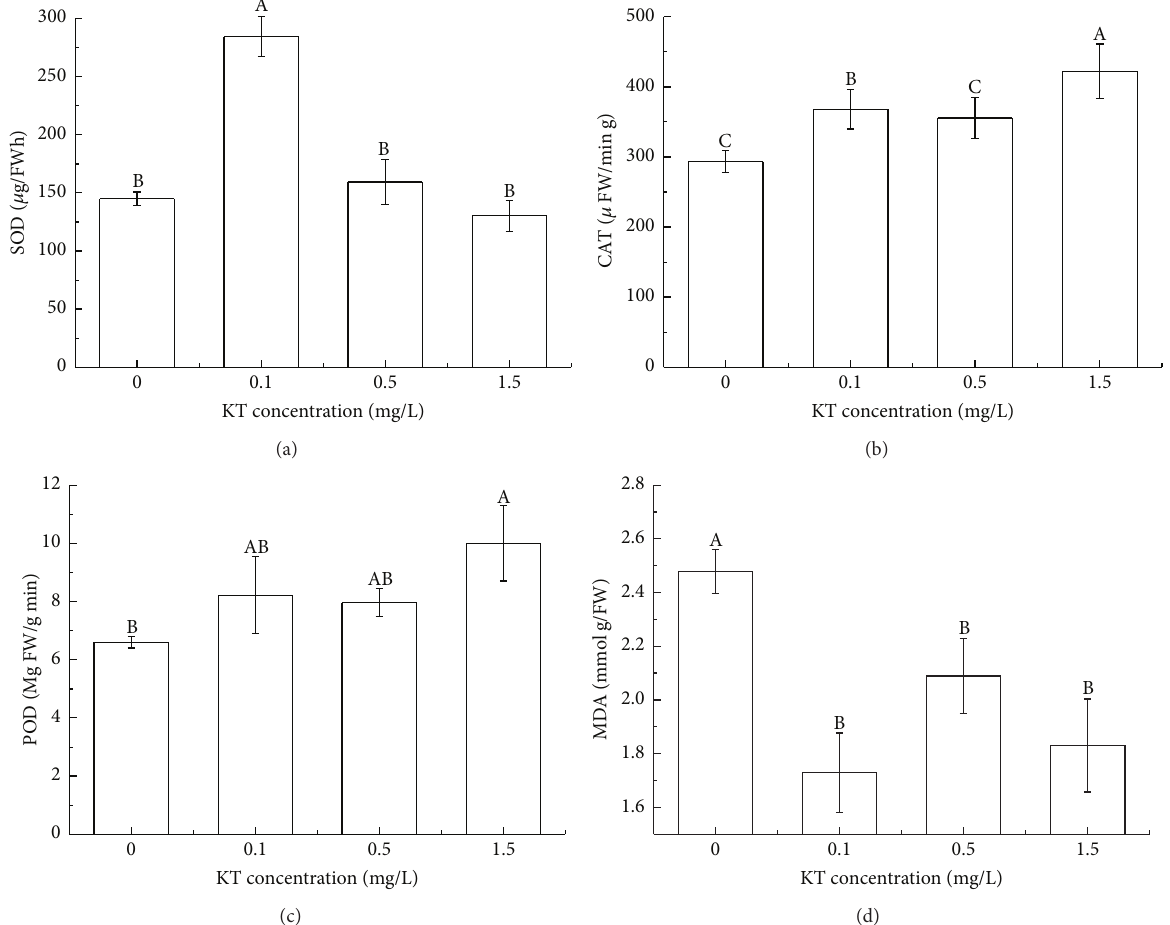
Figure 3: Effects of different concentrations of KT on the activity of antioxidative enzymes and MDA contents in maize seedlings under 0.5 mg/L arsenic stress. Values with different letters indicate a significant difference ( 𝑃 < 0.05